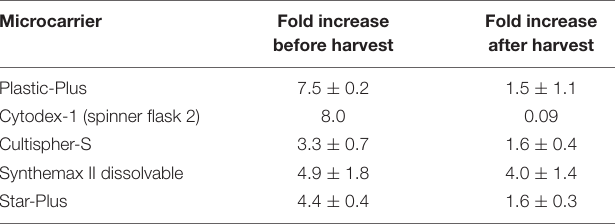
TABLE 2 | Fold increase data for hPDCs expanded during dynamic screening experiment of 8 days.